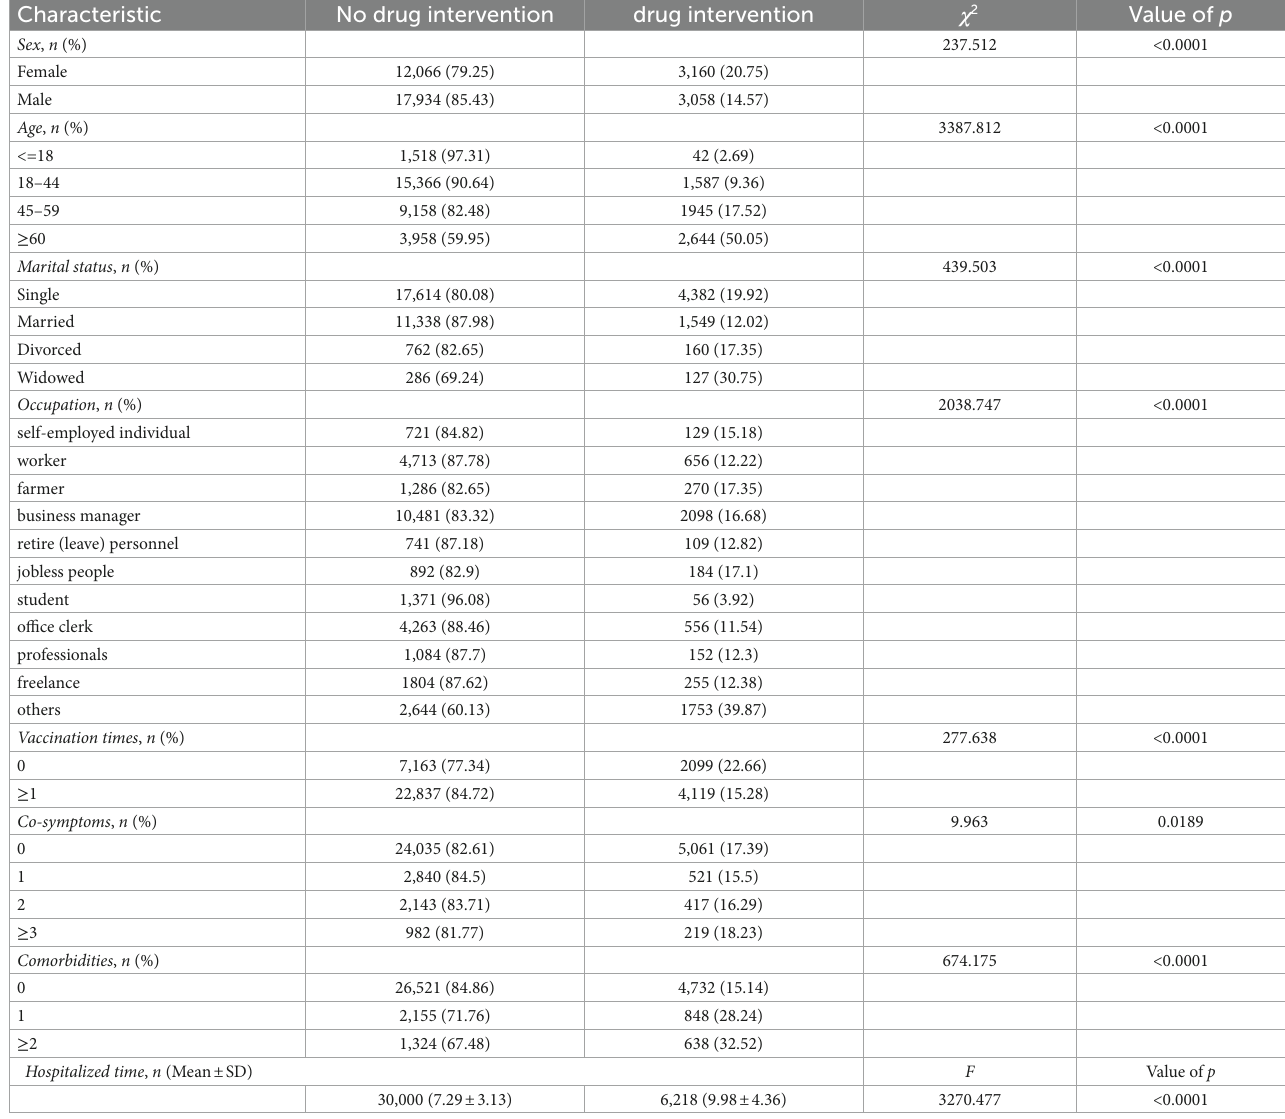
TABLE 2 Characteristics of the sample in different groups.